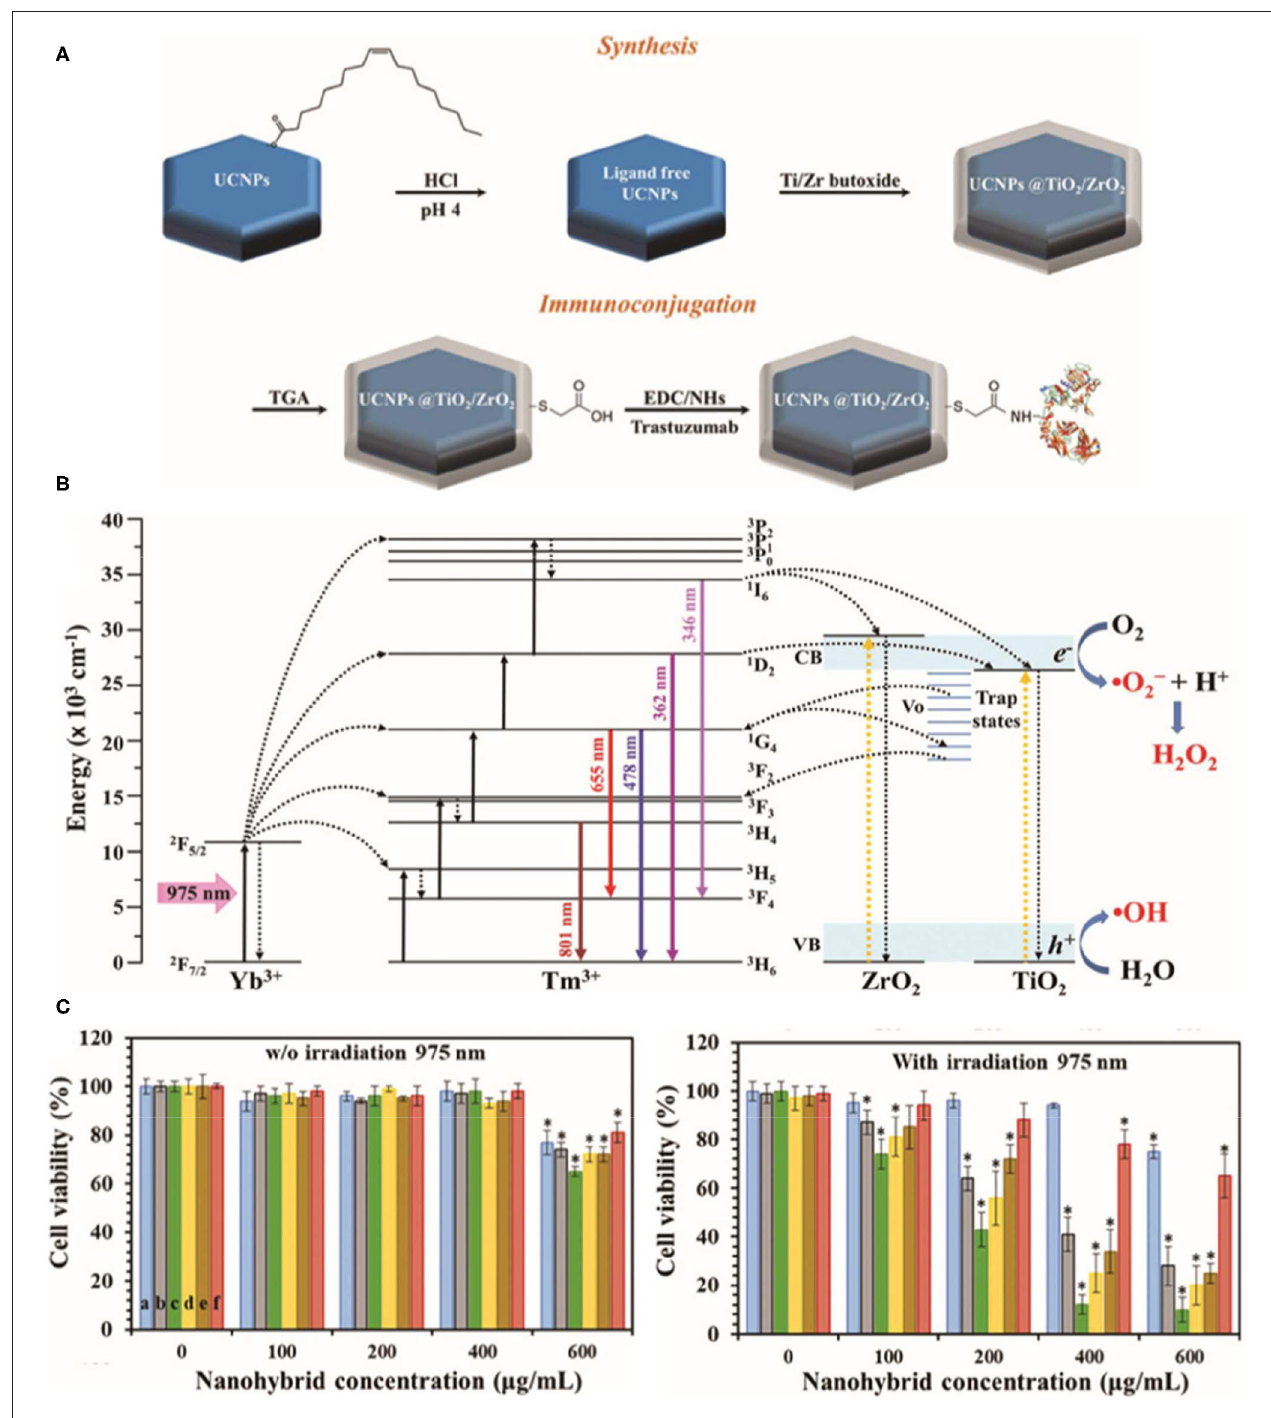
FIGURE 4 | Schematic illustration of the synthesis of the NaYF 4 :Yb,Tm@TiO 2 /ZrO 2 core@shell nanocomplex (A) and bioconjugation with trastuzumab. (B) Energy-level diagram of the upconversion, energy transfer, and reactive oxygen species (ROS) production processes in the NaYF 4 :Yb,Tm@TiO 2 /ZrO 2 nanocomplex under 975nm excitation. (C) alamarBlue assay to assess the cell viability of SKBR3 cells incubated with various nanocomplex concentrations without light exposure and upon 975nm continuous laser irradiation (0.71W cm − 2 ) during 5min. Reproduced with permission from Ramírez-García et al. (2019). Copyright (2019) Royal Society of Chemistry. * p <